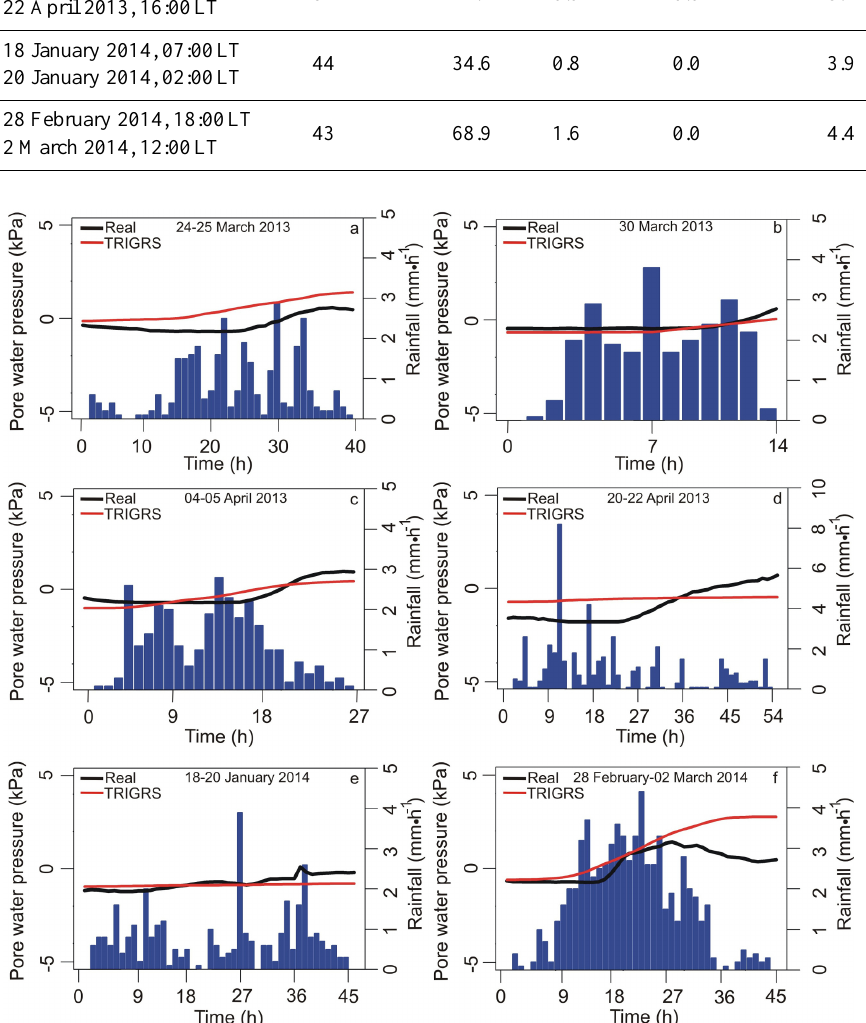
Figure 10. Comparison of measured and estimated TRIGRS-unsaturated pore water pressure trends at 1.2m from ground in correspondence of the monitoring station for selected rainfall events: (a) 23–25 March 2013; (b) 30 March 2013; (c) 4–5 April 2013; (d) 20–22 April